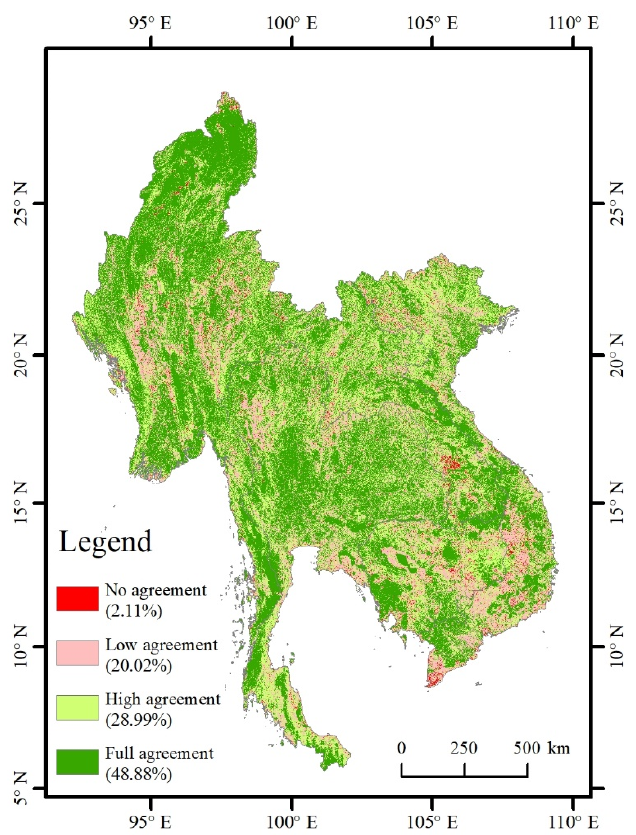
Figure 6. Overall pixel identification spatial consistency of multisource LULC datasets.